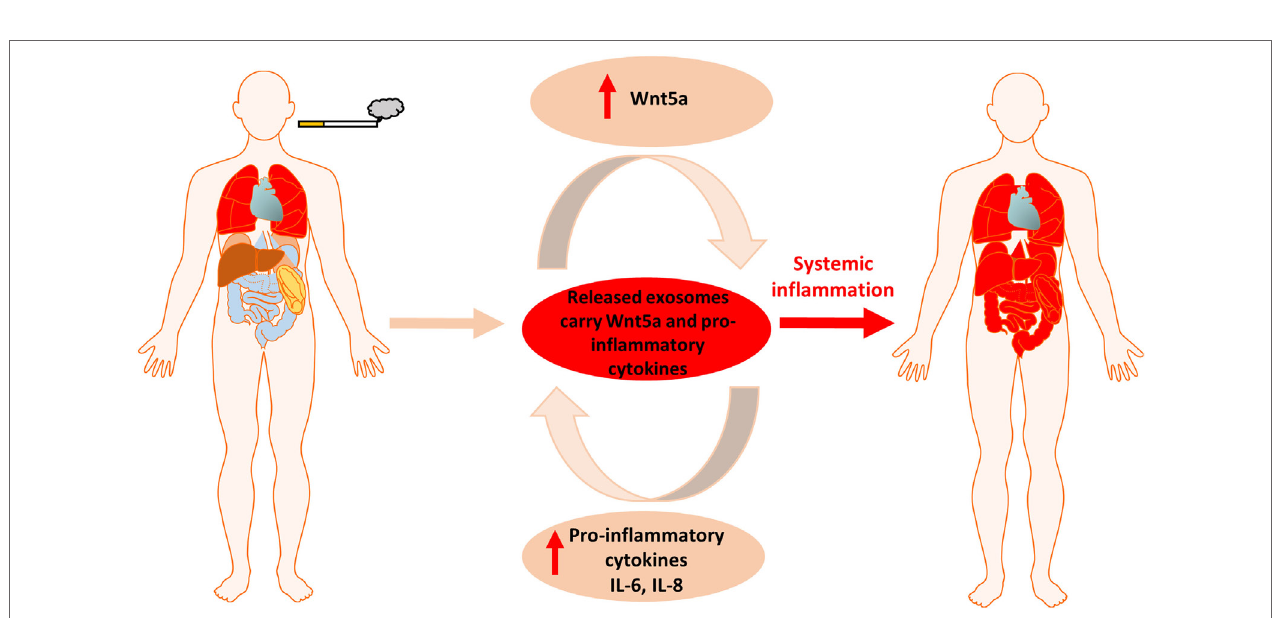
FigUre 6 | Summary figure of cigarette smoke induced local inflammation becoming systemic by the contribution of Wnt5a and inflammatory